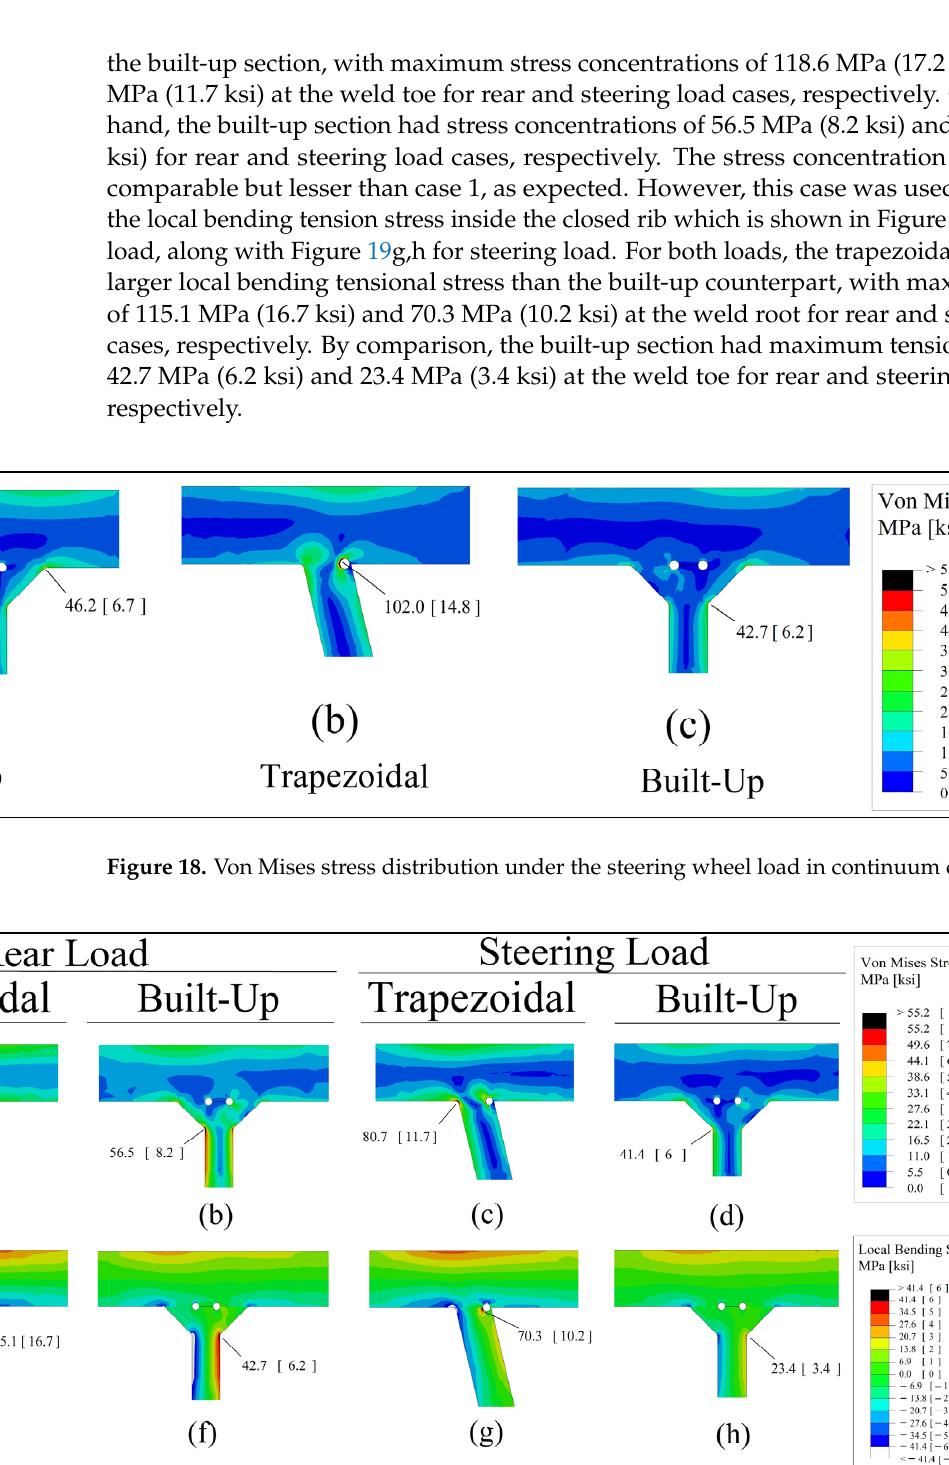
Figure 19. Von Mises and local bending stress distributions under the rear and steering wheel loads in continuum case 2.